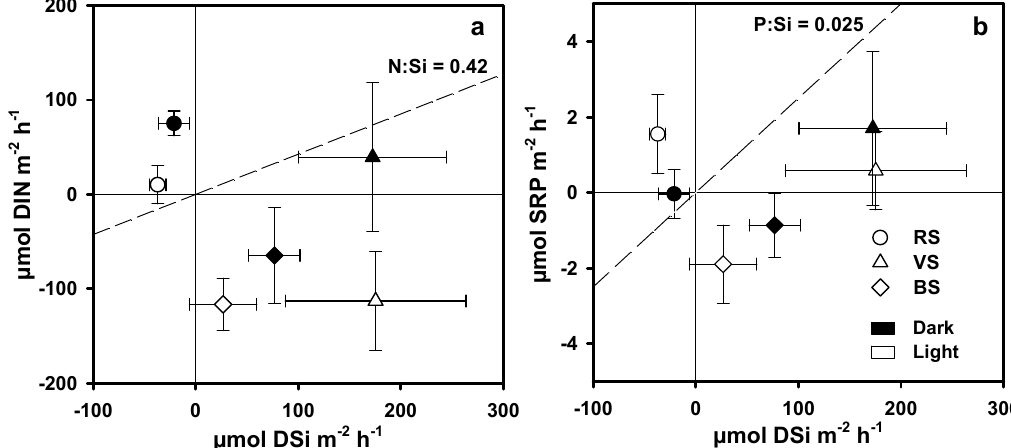
Figure 5. Average DSi:DIN ( a ) and DSi:SRP ( b ) ratios of benthic fluxes under light and dark conditions in the three sampling sites. Error bars represent standard error (n = 18). Legend: RS = rocky shores; VS = vegetated sediments; BS = bare sediments.